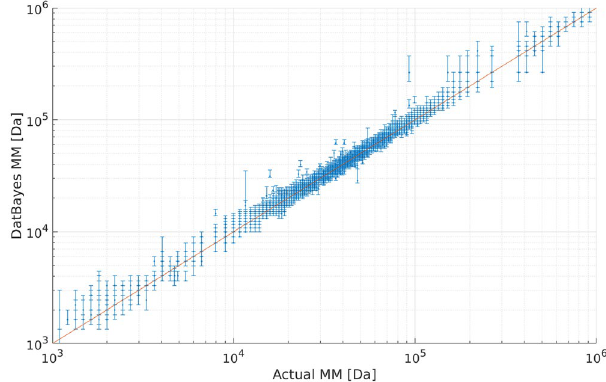
Figure 9. Credibility interval from Bayesian inference. Scatter plot of DatBayes MM against actual MM for ideal data. Both axis are log-scaled. The bars indicate the width of the probability distribution containing 90% of the probability mass. Note the larger bars for very small and large proteins, a result of the limited training data in these ranges of